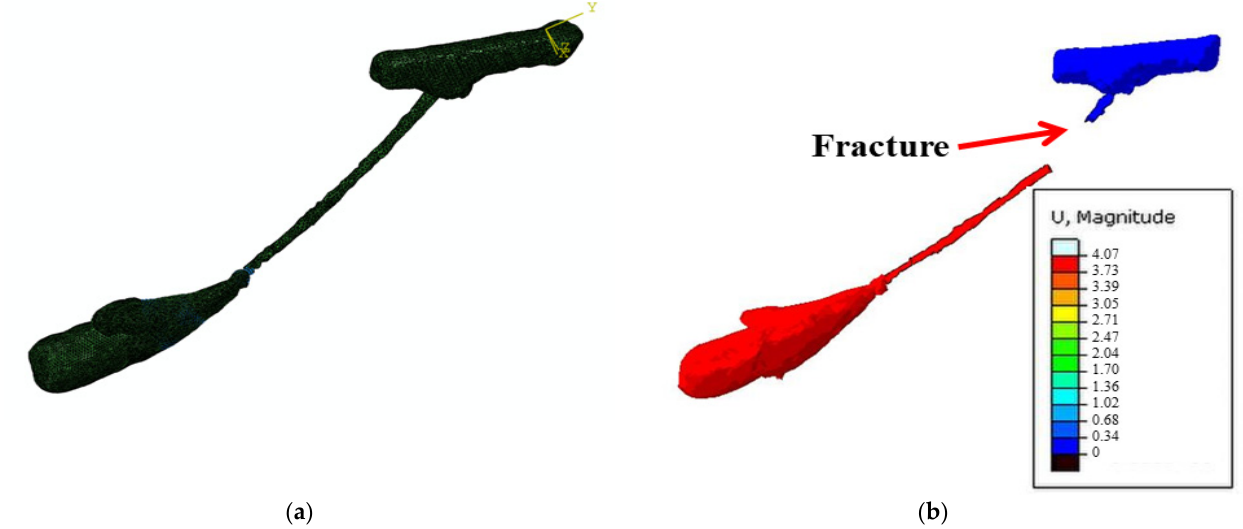
Figure 4. The meshed model ( a ) and the result ( b ) of the unripe fruit in the detachment simulation.